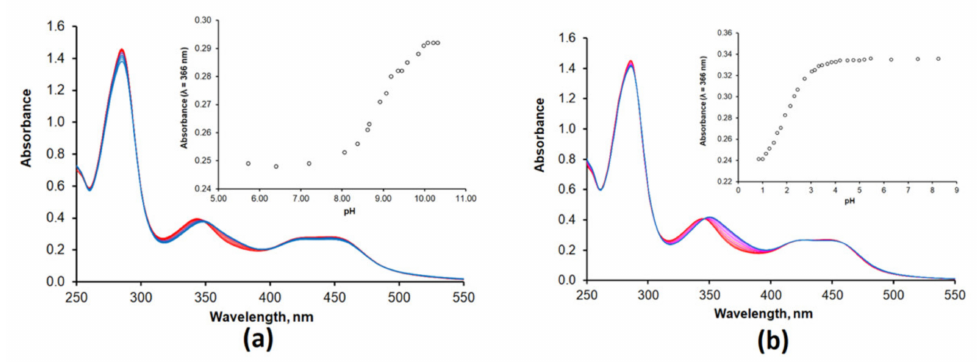
Figure 1. Evolution of the electronic absorption spectra of the compound Ru(N 2 phen) ([ Ru(N 2 phen) ] tot = 33 µ M) ( a ) and Ru(N 2 P 2 phen) ([ Ru(N 2 P 2 phen) ] tot = 21 µ M) ( b ) as a function of pH. The range of pH 1–12 was investigated for both complexes, but only the region of pH changing (see insets) are shown in the figure. Insets show the pH dependence of the absorbance at λ abs = 336 nm.